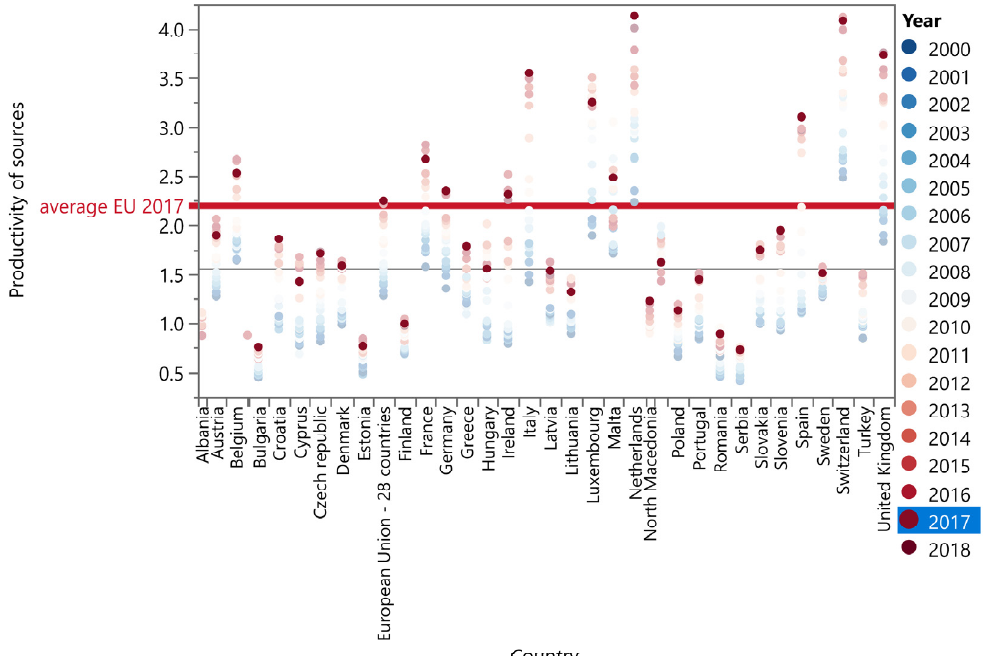
Figure 4. Graphical comparison of resources productivity in EU in 2000–2018.